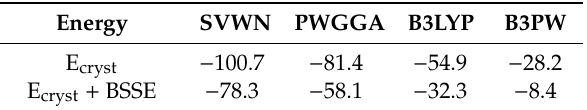
Table 4. Lattice energies (E cryst ) before and after counterpoise correction calculated with different exchange and correlational functionals (all energies are in kcal/mol) using the 6-31G(d,p) basis set. The experimental geometry has been adopted.